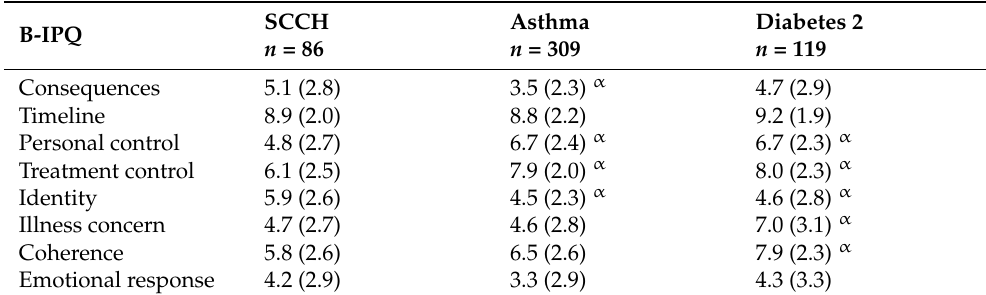
Table 3. Comparison of Brief Illness Perception Questionnaire scores between SCCH patients and different patient